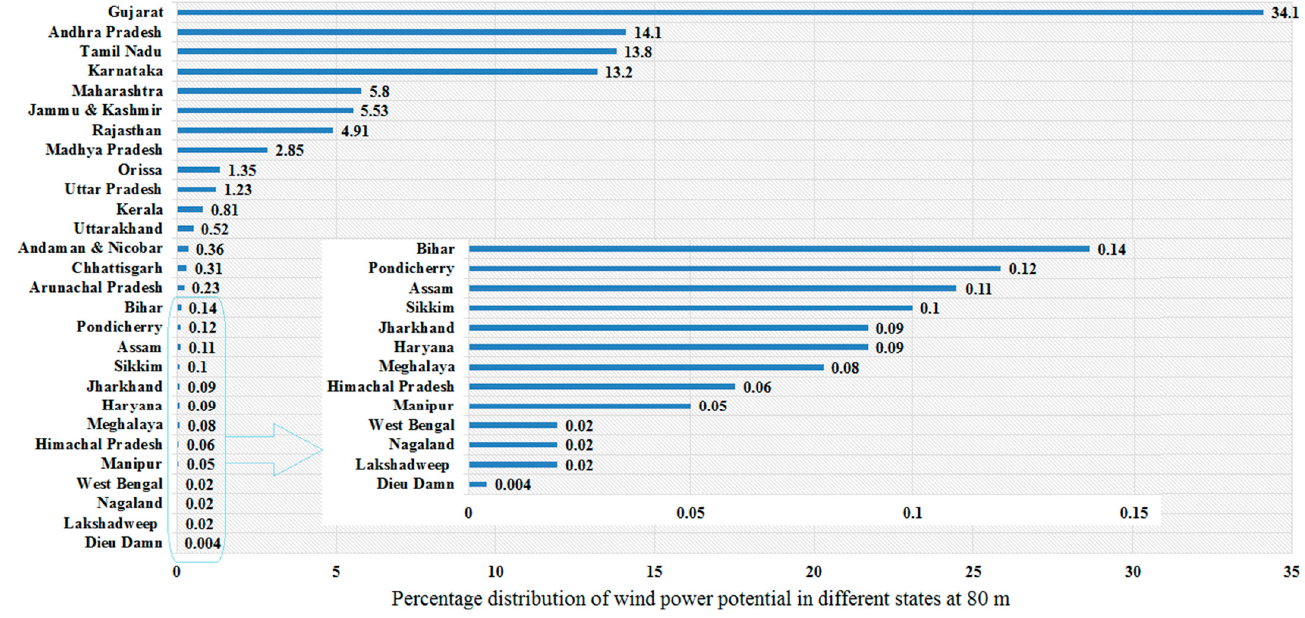
Figure 12. Percentage distribution of wind power potential in different states at 80 m AGL [58].